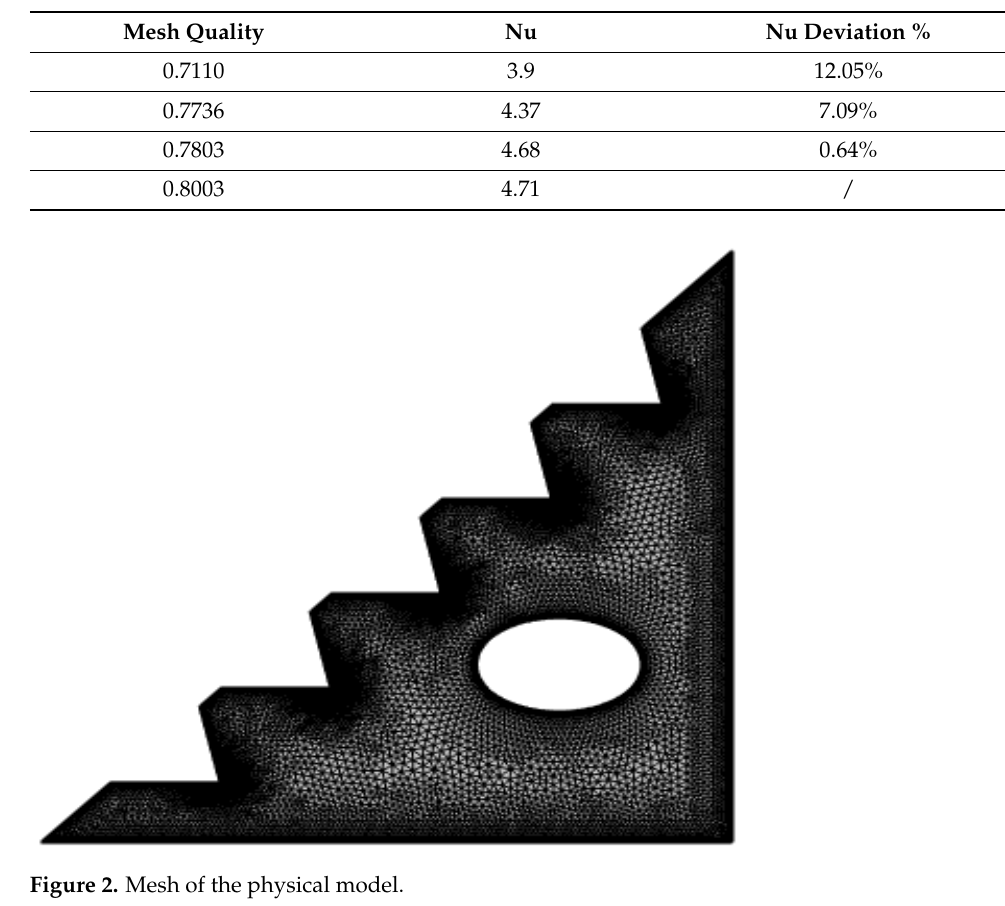
Table 3. Grid-independence test.